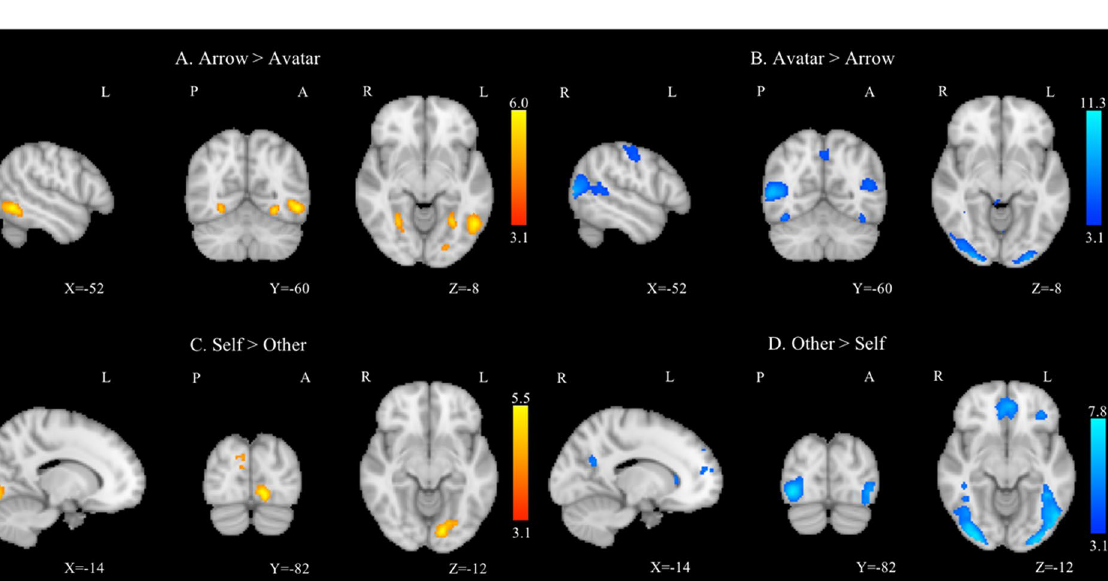
Table 3. Results of simple mixed regression models focusing on differences between the main conditions: linear for mean reaction times and logistic for errors. N = 82 participants.